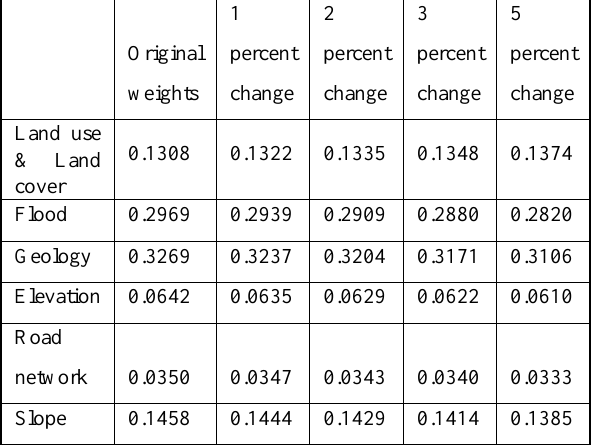
Table 4: Percentage of suitability areas from sensitivity analysis